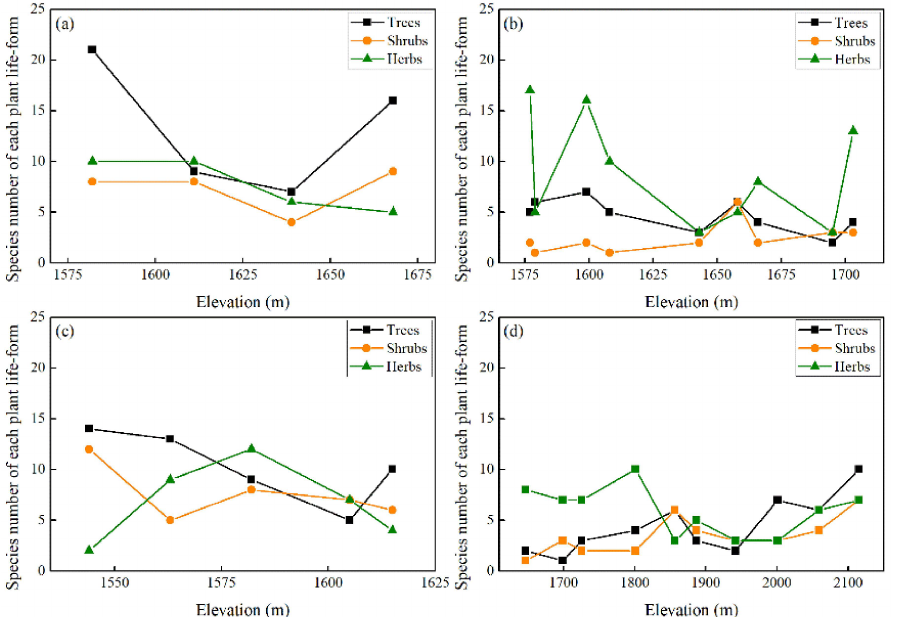
Figure 7. Variation in the number of species of each plant life-form as altitude increased: ( a ) Jincheng Park; ( b ) Renshoushan Park; ( c ) Baitashan Park and ( d ) Lanshan Park.